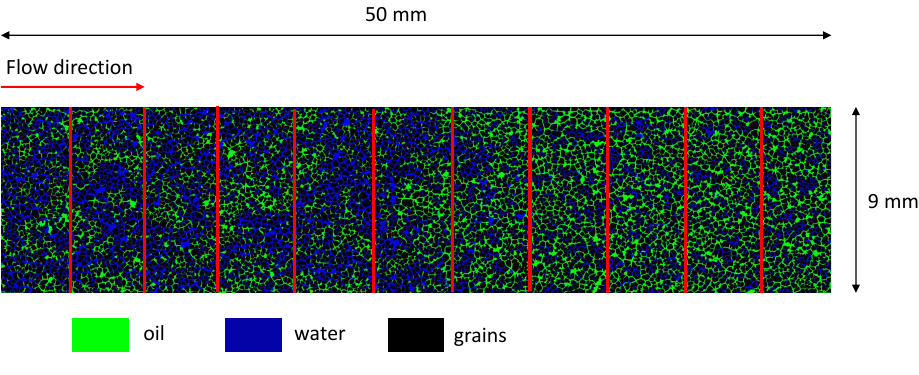
Figure 7. Image segmentation.